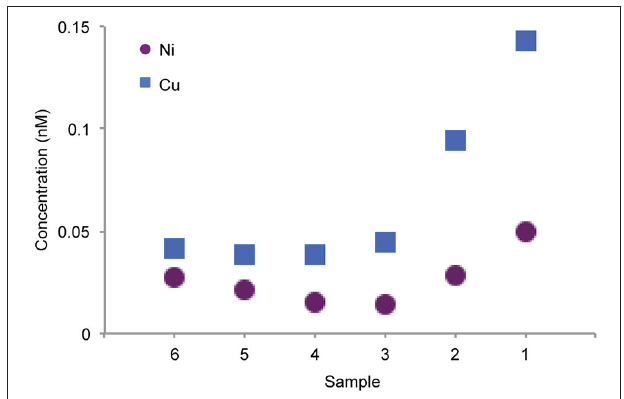
FIGURE 3 | Concentration of Cu and Ni complexes detected by LC-ICPMS from the six integrated surface samples.